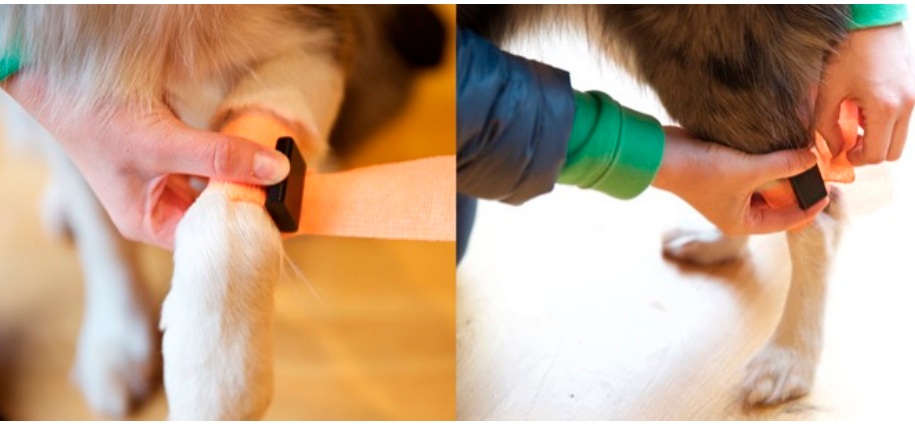
Figure 1 . Sensors were attached in the positions shown and secured with coloured cohesive bandages.